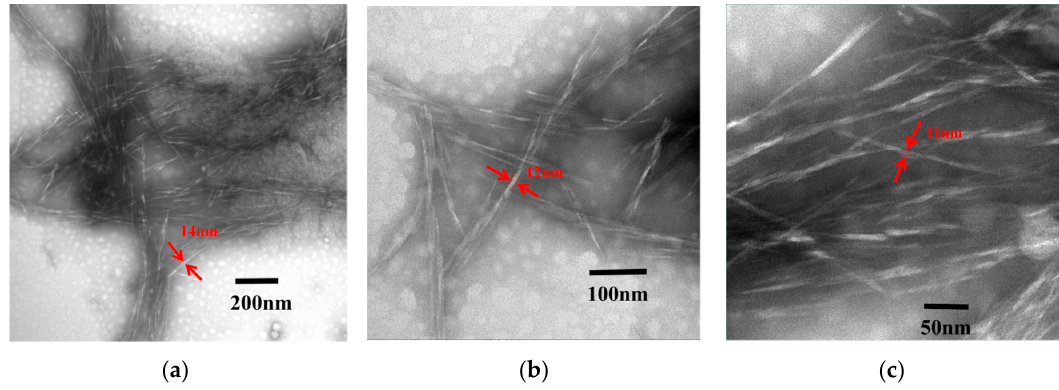
Figure 4. TEM images under different ruler conditions ( a , 200 nm; b , 100 nm; c , 50 nm) of Artemisia vulgaris bast nanocellulose fibers.